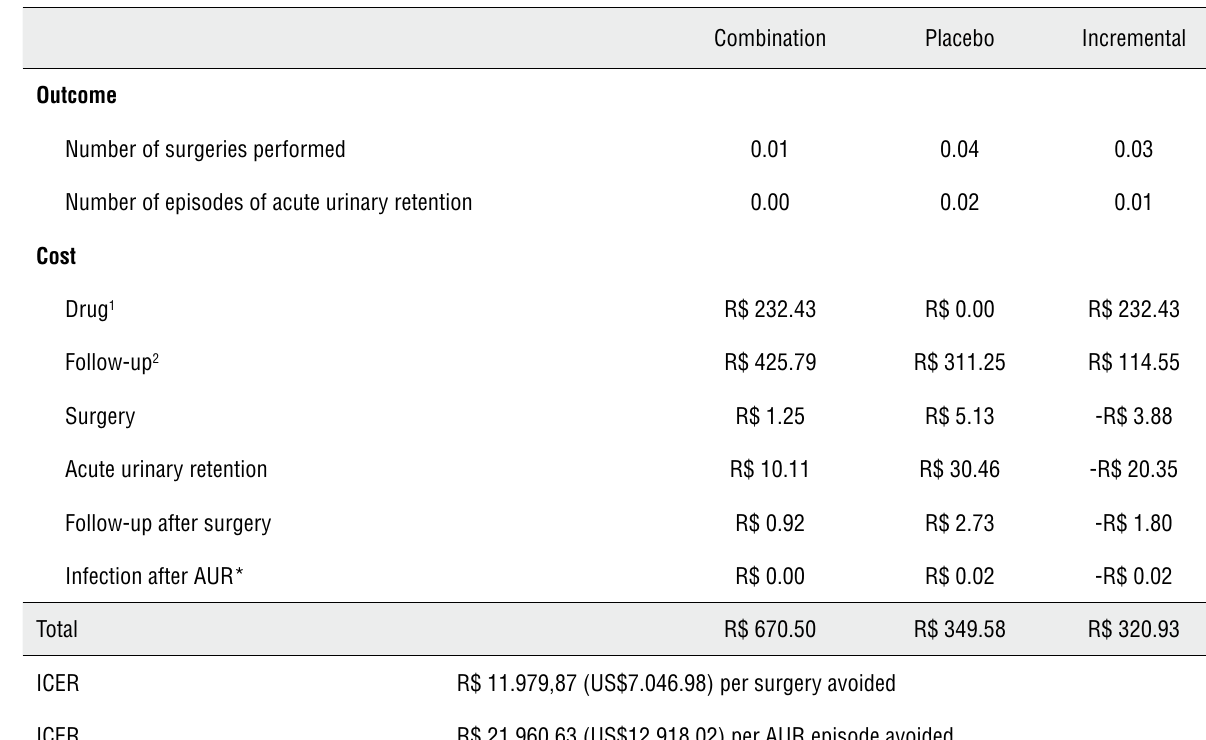
Table 2 - Efficacy and incremental costs with the combination of doxazosine + finasteride or placebo in a 4 year period (per